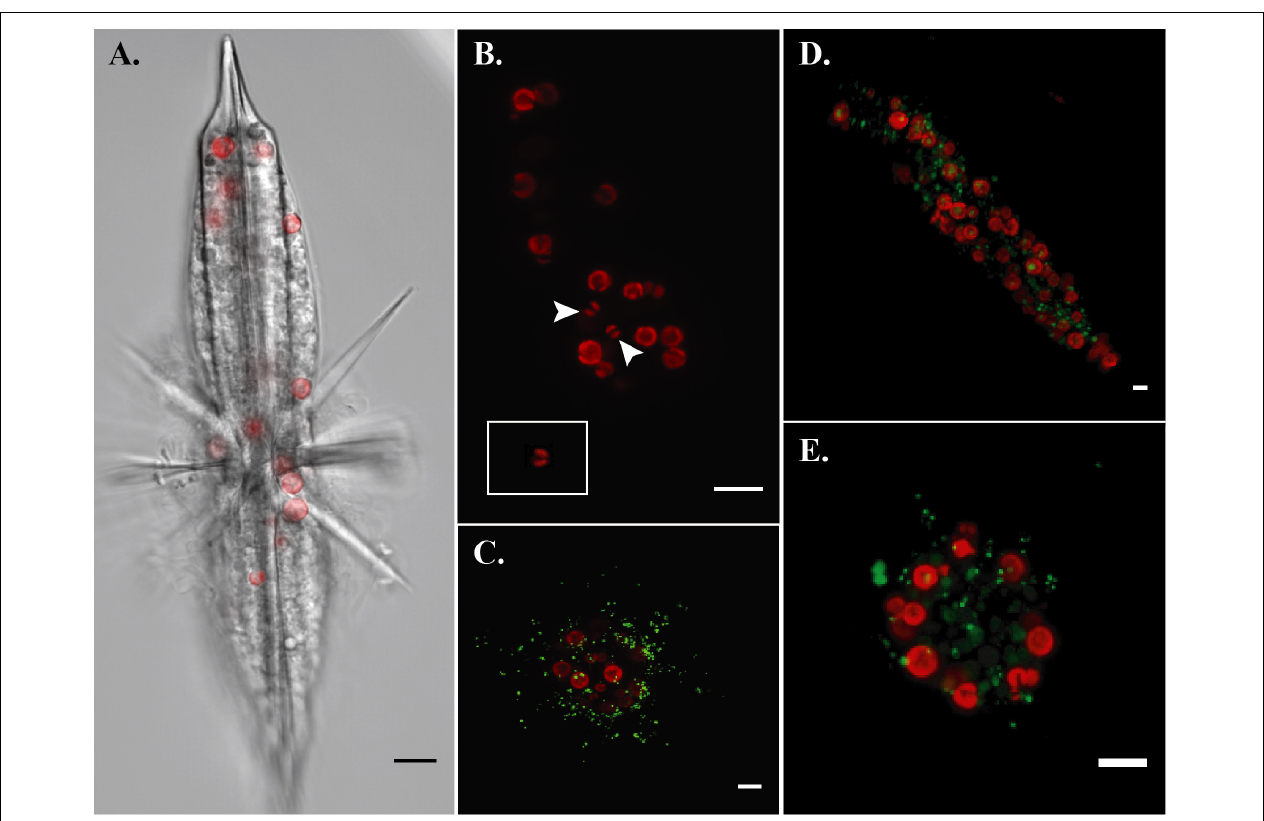
FIGURE 6 | Fluorescent confocal microscopy of acantharians and their symbionts. (A) Single optical slice displaying autofluorescence of symbiont chlorophyll (red) and halogen light imaging of an entire host, sample Oki.3A. (B) Maximum projection of a z-stack spanning the entire host sample Oki.4A, which contains 17 visible symbionts and 10 symbiotic sequence variants. Arrows indicate symbionts presenting the free-living phenotype: smaller cell diameter and two elongate, parietal chloroplasts, which is also visible in the inset image of a Phaeocystis globosa CCMP1528 cell in culture that was imaged following the same methods. Red fluorescence is chlorophyll autofluorescence. (C–E) Maximum projections of z-stacks spanning entire hosts collected near Okinawa in December 2017. Red fluorescence is symbiotic chlorophyll autofluorescence. Green fluorescent staining is LysoTracker Green, which selectively binds to low-pH digestive-organelles, including lysosomes and phagolysosomes. Symbionts are not held in phagolysosomes and lysosomes are not concentrated around symbionts, indicating that symbionts are not actively being digested. Scale bars are 10 µ m in all